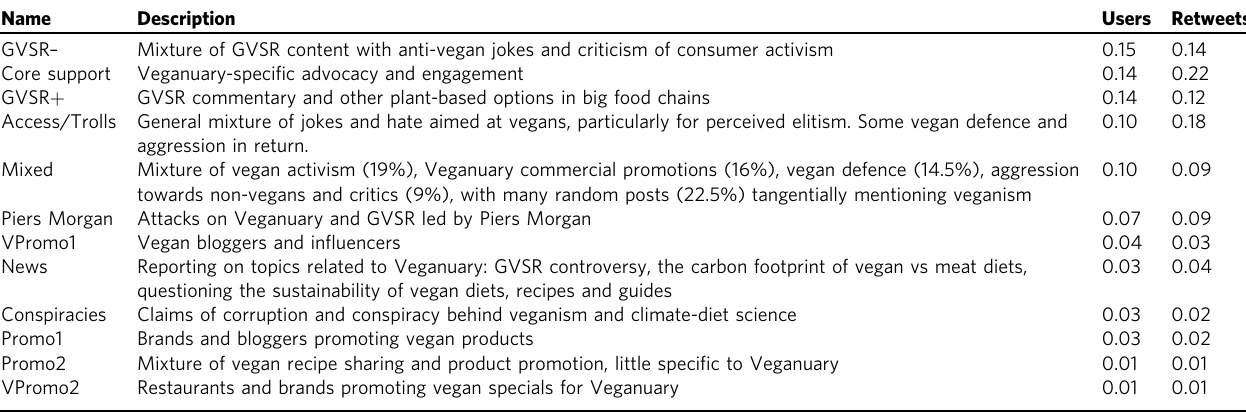
Table 1 Descriptive table of the top 12 communities in the retweet